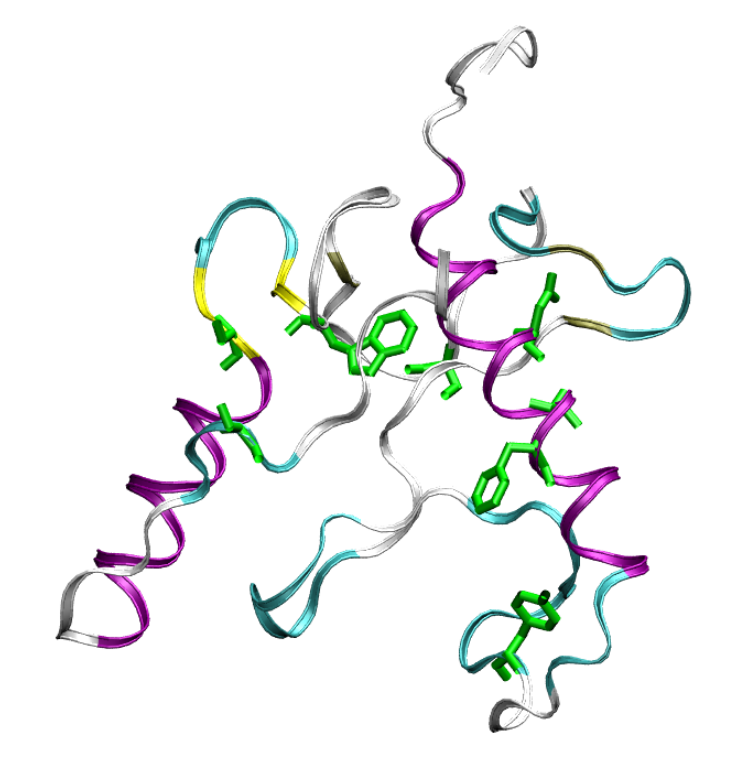
Figure 3. Structure of FXN, WT sequence, with S α ,1 = 13, S α ,2 = 6.6, S β ,1–4 = 2 (see also Table 2). The drawing is made as in Figure